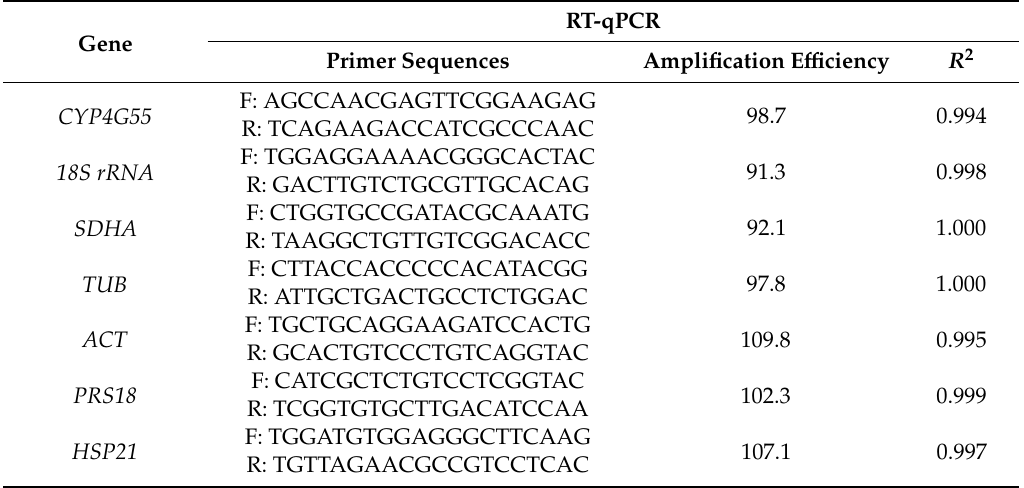
Table 1. Primer sequences, product sizes, and PCR e ffi ciencies for the assessed genes.